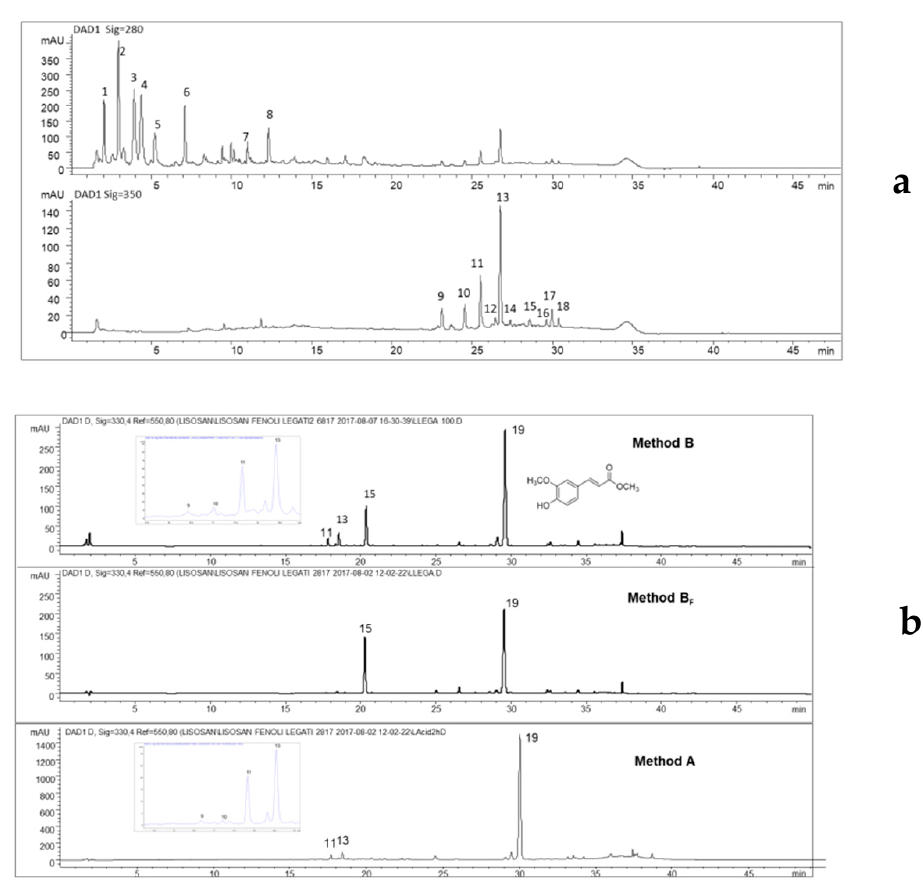
Figure 1. ( a ) Chromatographic profiles at 280 and 350 nm of the aqueous extract of Lisosan ® G on the Poroshell column, obtained applying the same gradient elution used for the semipreparative HPLC. Compounds 1 – 8 , unknowns; 9 and 10 , neocarlinoside or its isobars, isocarlinoside/carlinoside; 11 , isoschaftoside; 13 , schaftoside; 15 , ferulic acid; 16 – 18 unknowns; and ( b ) comparison of the HPLC profiles at 330 nm obtained for bound phenols with methods B and A on the whole flour, method B F on the residue from free phenol extraction; 9 and 10 , neocarlinoside/isocarlinoside/carlinoside; 11 , From experimental data collected on the fractions by HRMS n and from the results in the literature on wheat [11–13], it was possible to identify a group of C -glycosylated flavonoids ( 9 – 11 and 13 ) present only in two of the fractions from semipreparative HPLC (Figure